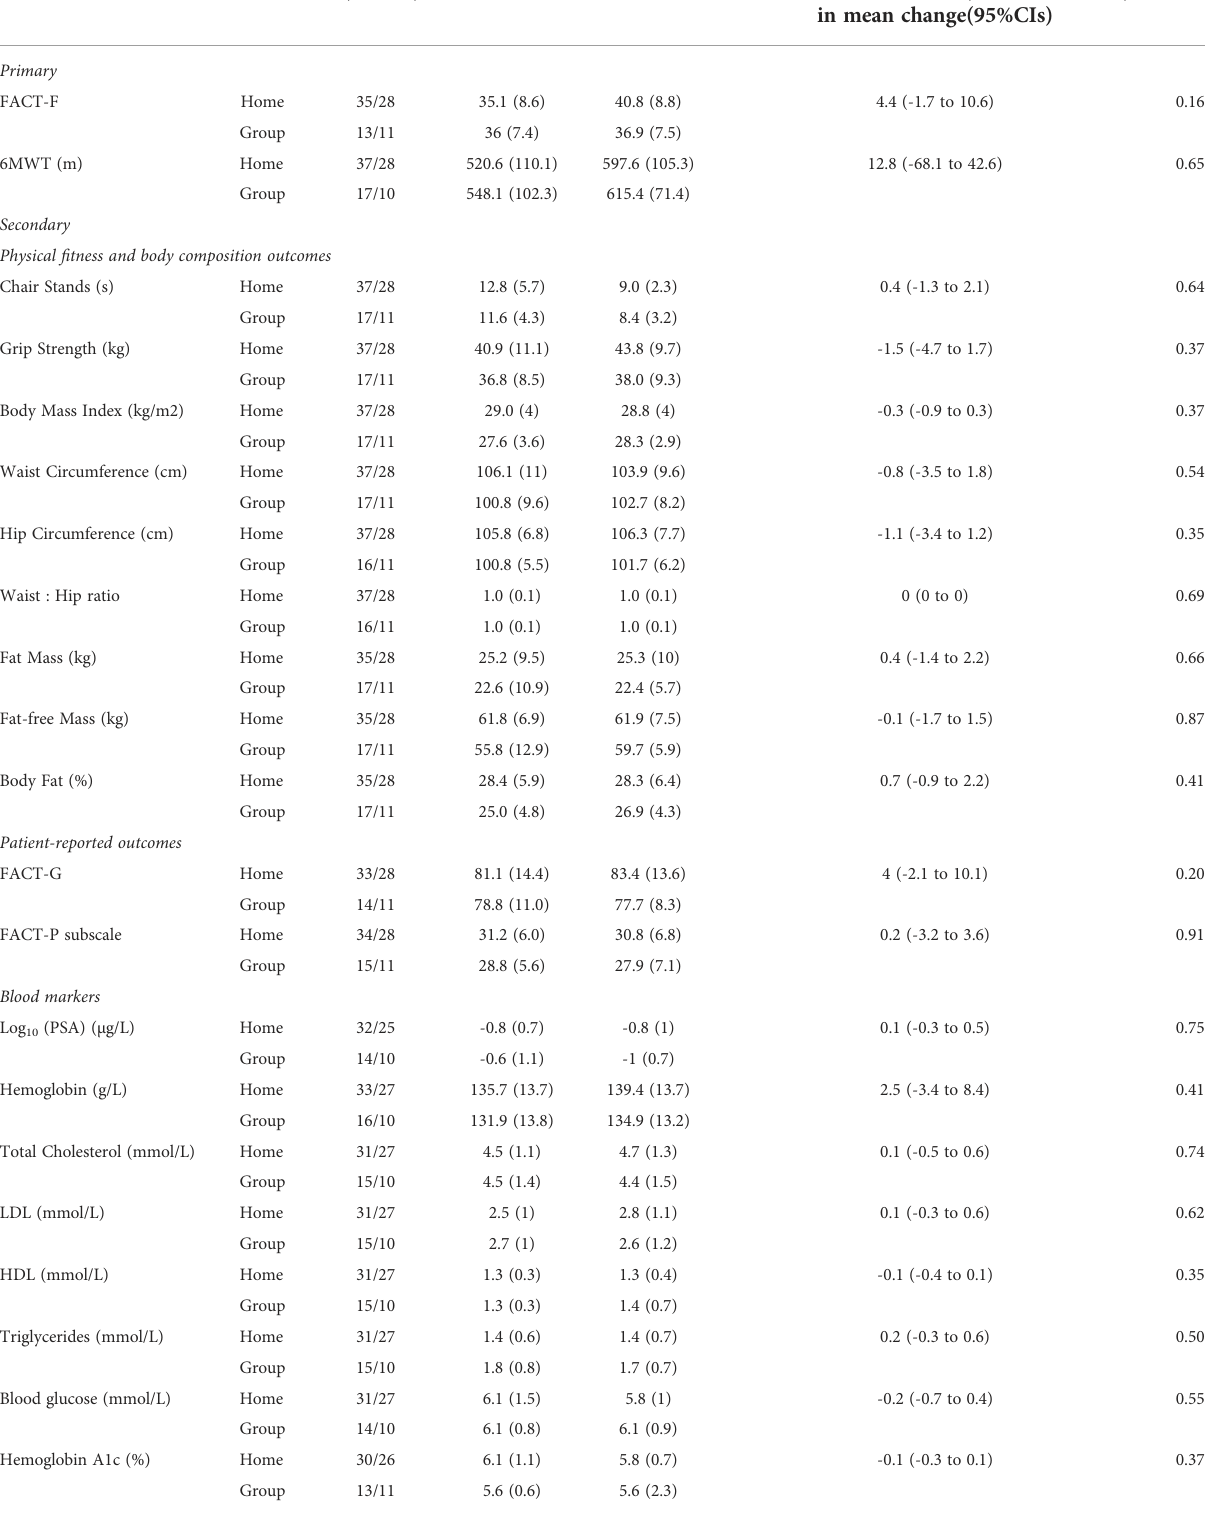
TABLE 4 Differences in changes from baseline to 6 months in primary and secondary outcomes (preference-based participants only). Outcomes Arm n(BL/6m) Baseline 6 Months